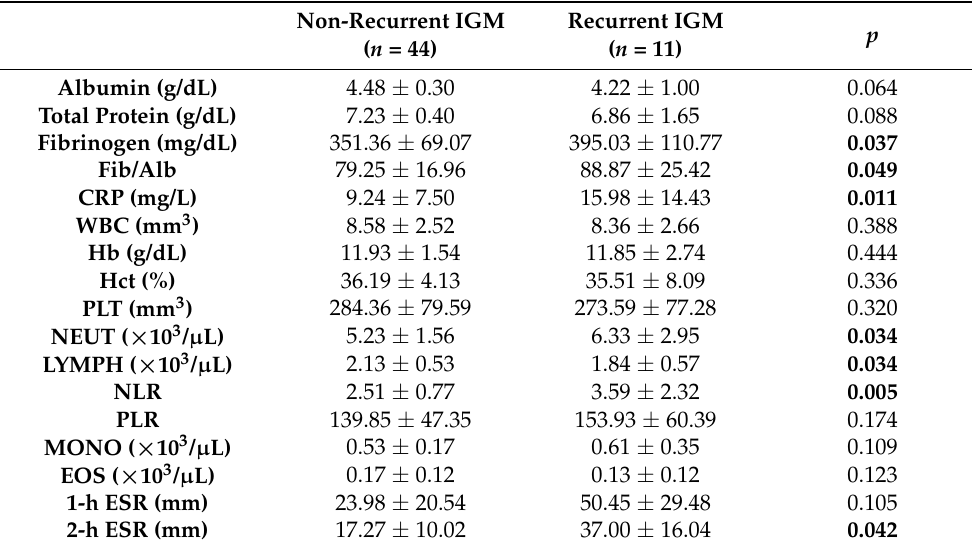
Table 6. Biochemical laboratory findings and hematological indexes of patients with non-recurrent and recurrent IGM.